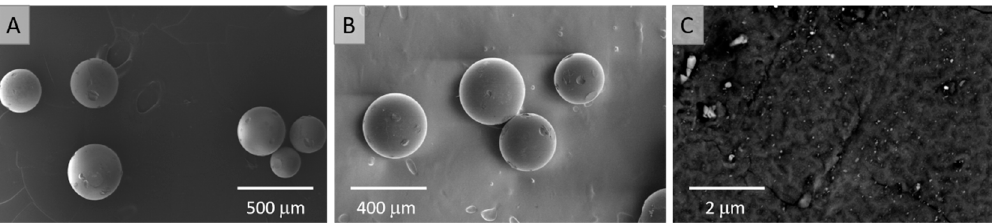
Figure 3. SEM photomicrographs of the Re@NCat sample. ( A ) The CIM-functionalized anion exchange resin, ( B ) the Re@NCat, ( C ) the surface morphology of the Re@NCat.